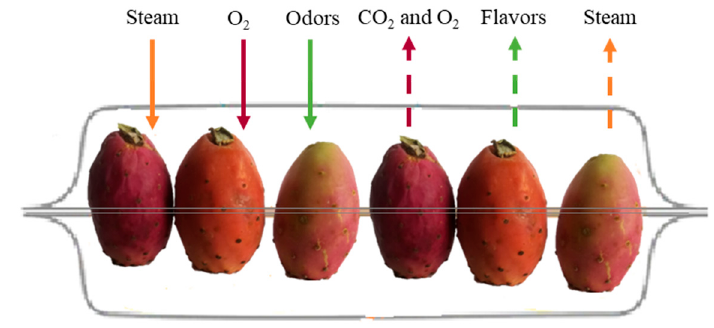
Figure 7. Transfers that occur through modified atmosphere packaging [7]. Piga et al. (2003) investigated possible changes in ascorbic acid and polyphenols levels in whole PP, manually peeled and packaged in passive MAP. The mass decrease of the PP was low, with a maximum of 0.15 g/100 g, after nine days at 4 ◦ C. The minimal processing applied to the PP did not indicate a significant decrease in ascorbic acid and polyphenols levels nor in their antioxidant capacity. Despite being significantly altered during storage, other parameters, such as acidity and pH, did not harm sensory parameters